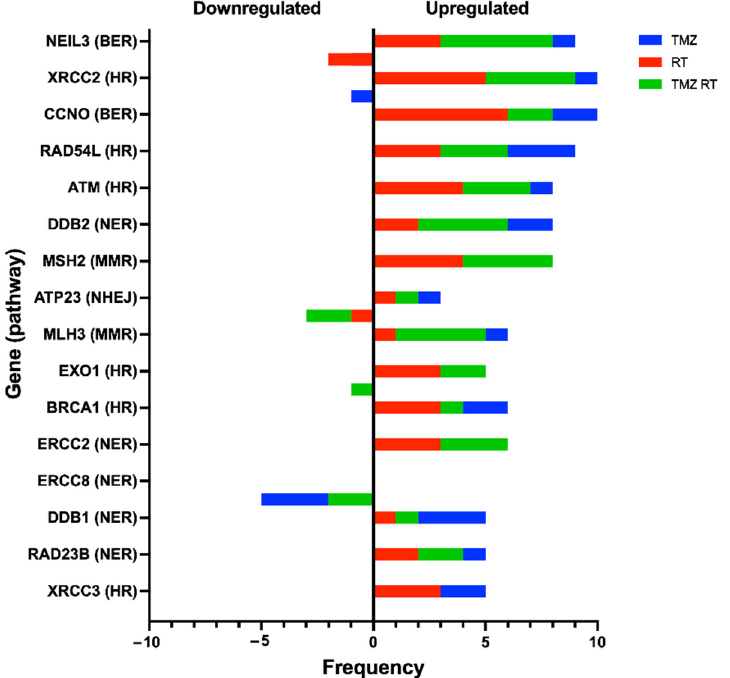
Figure 6. Top 16 most frequently up- or downregulated genes across all four glioblastoma cell lines (FPW1, HW1, SB2b and MN1). Data include the accumulated frequency across all variables for each respective gene, including the number of upregulated (positive values) or downregulated (negative values) occurrences, and the occurrence of this change in each specific treatment (TMZ = blue, RT = red, TMZ RT = green).